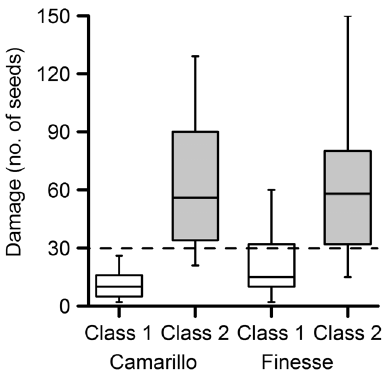
Figure 3. The damage threshold between class 1 and class 2 fruit. Boxplots of the amount of damage on class 1 (empty bars) and class 2 (shaded bars) strawberry red fruit for cultivars Camarillo and Finesse from the pack-house in 2012, suggesting a damage threshold around 30 seeds (dashed line). Damage was recorded as the number of seeds surrounded by bronzing at harvest. Bars indicate the inter- quartile range (50% of values) and the horizontal line indicates the median. The vertical bars indicate the data range excluding any outliers.